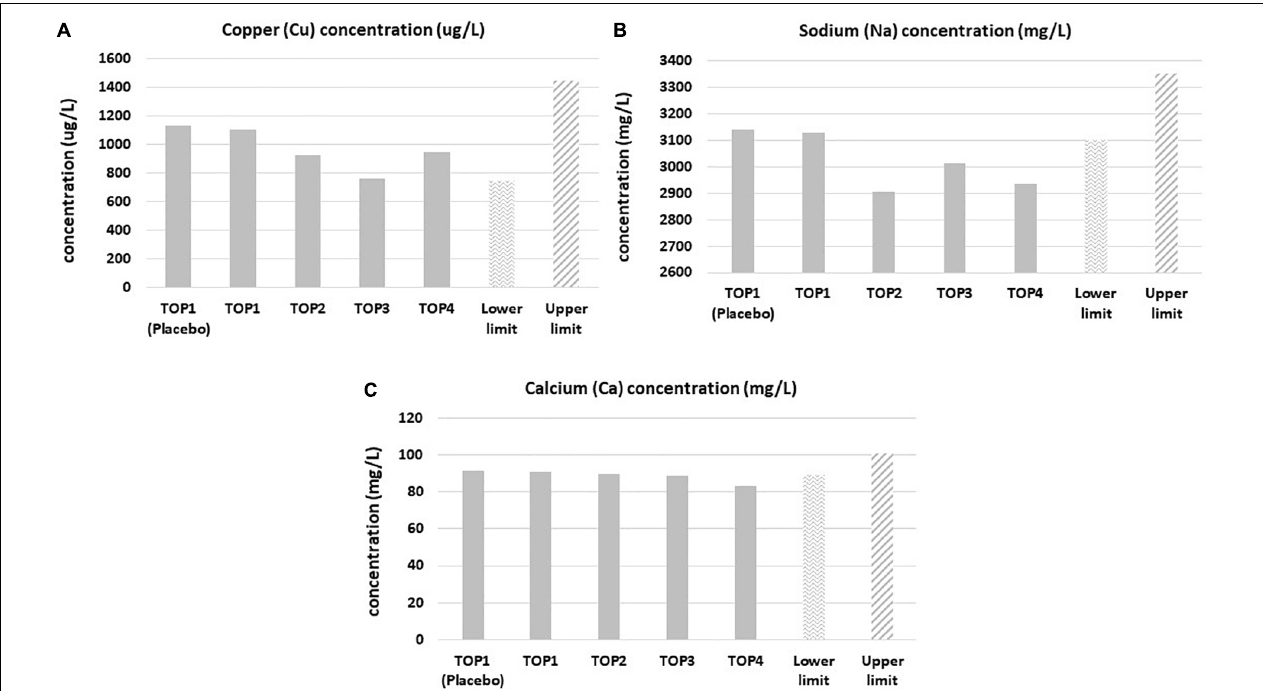
FIGURE 2 | Copper (A) , sodium (B) , and calcium (C) blood levels in the Placebo and Verum groups during the osteoporosis TOP study course of 4 years with corresponding limits of the referent values. Statistically significant lower levels ( post-hoc , p < 0.05) were observed in the third year for copper, sodium and calcium and in the fourth year for calcium and sodium in comparison with the lower referent values. TOP1-Placebo (without PMA-zeolite supplementation); TOP1-Verum, end of the first year of PMA-zeolite supplementation; TOP2-Verum 2Y, end of the second year of PMA-zeolite supplementation; TOP3-Verum 3Y, end of the third year of PMA-zeolite supplementation; TOP4-Verum 4Y, end of the fourth year of PMA-zeolite